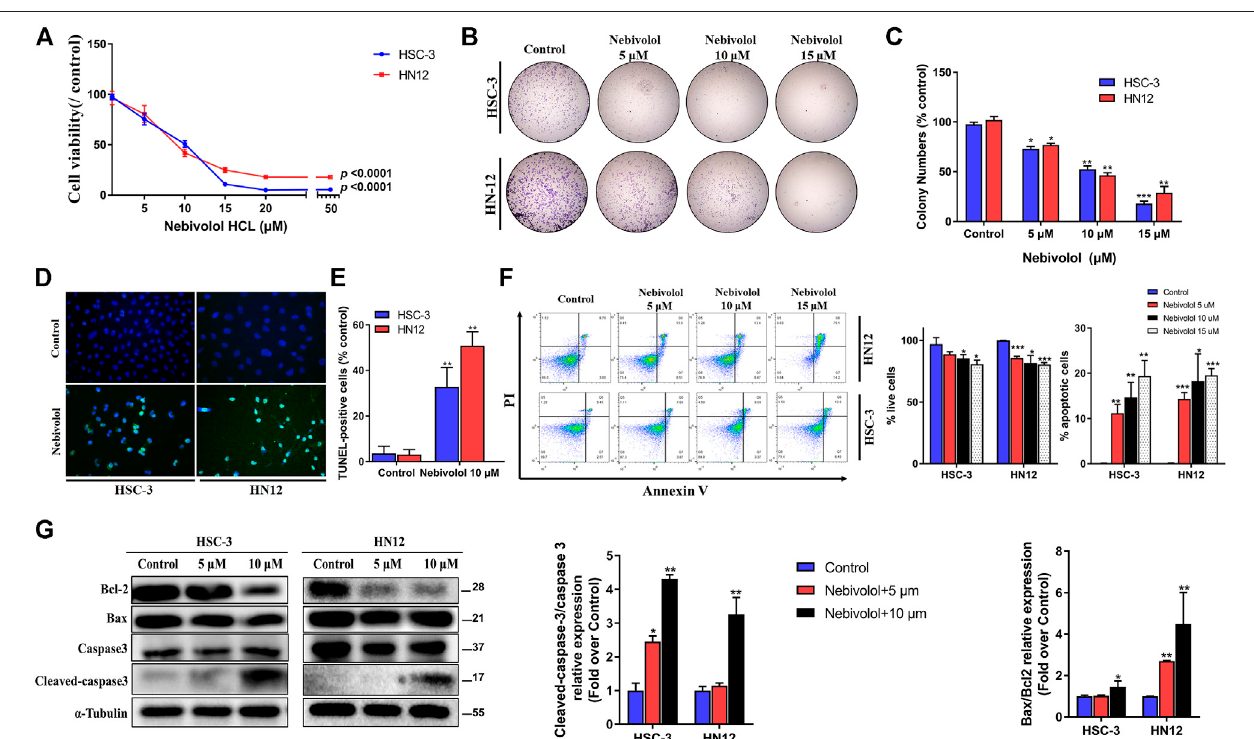
FIGURE 3 | Nebivolol inhibited the growth in OSCC cells. (A) The CCK-8 assay was used to determine the cytotoxicity of nebivolol on HSC-3 and HN12 cells at different concentrations for 24 h. (B, C) Colony formation assay of HSC-3 and HN12 cells treated with the indicated concentrations of nebivolol. Representative images (B) andquanti fi cationofcolonies (C) wereshown. (D,E) TUNELassayinnebivolol-treatedcells.Representativeimages (D) andquanti fi cationofTUNEL-positivecells (E) wereshown.Scalebar,100 μ m. (F) CelldeathassayusingAnnexinV/PIstainingand fl owcytometrictodeterminetheeffectsofnebivololonHSC-3andHN12cells death. The proportion of live cells and apoptotic cells was quanti fi ed. (G) Western blotting of total and cleaved-caspase 3, Bcl-2, and Bax in OSCC cells after being treatedwiththeindicatedconcentrationsofnebivololfor24 h.TheBax/Bcl2andcleaved/totalcaspase3fromtheblotswerequanti fi ed.Datarepresentthemean ± SDof three replicate independent experiments. The asterisk (*) indicates a signi fi cant difference compared to the control group (* p < 0.05, ** p < 0.01, and *** p <